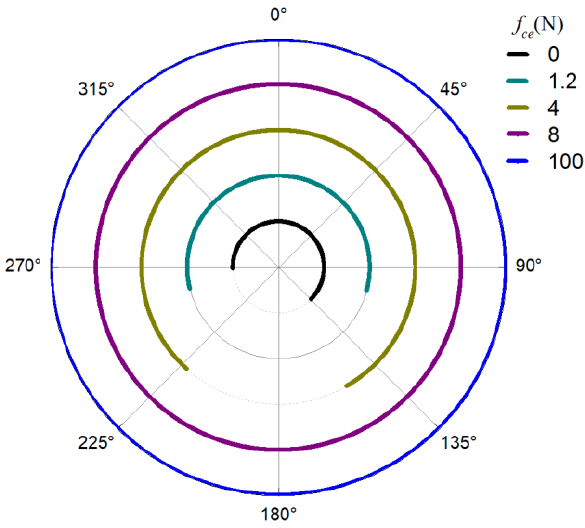
Figure 25. Time-domain diagram of the load region ( f ce = 100 N).